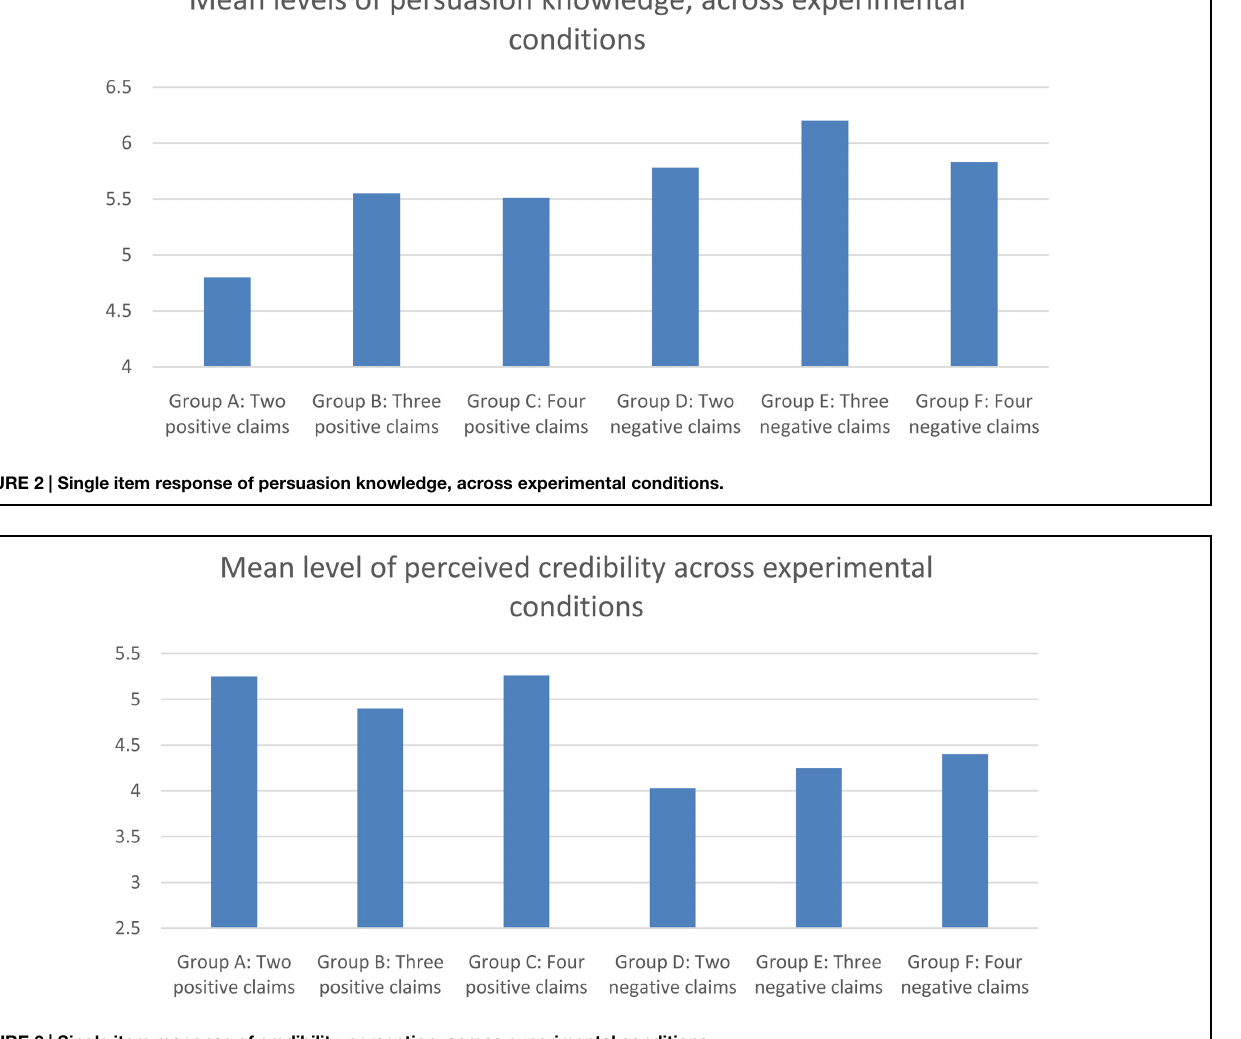
FIGURE 3 | Single item response of credibility-perception, across experimental